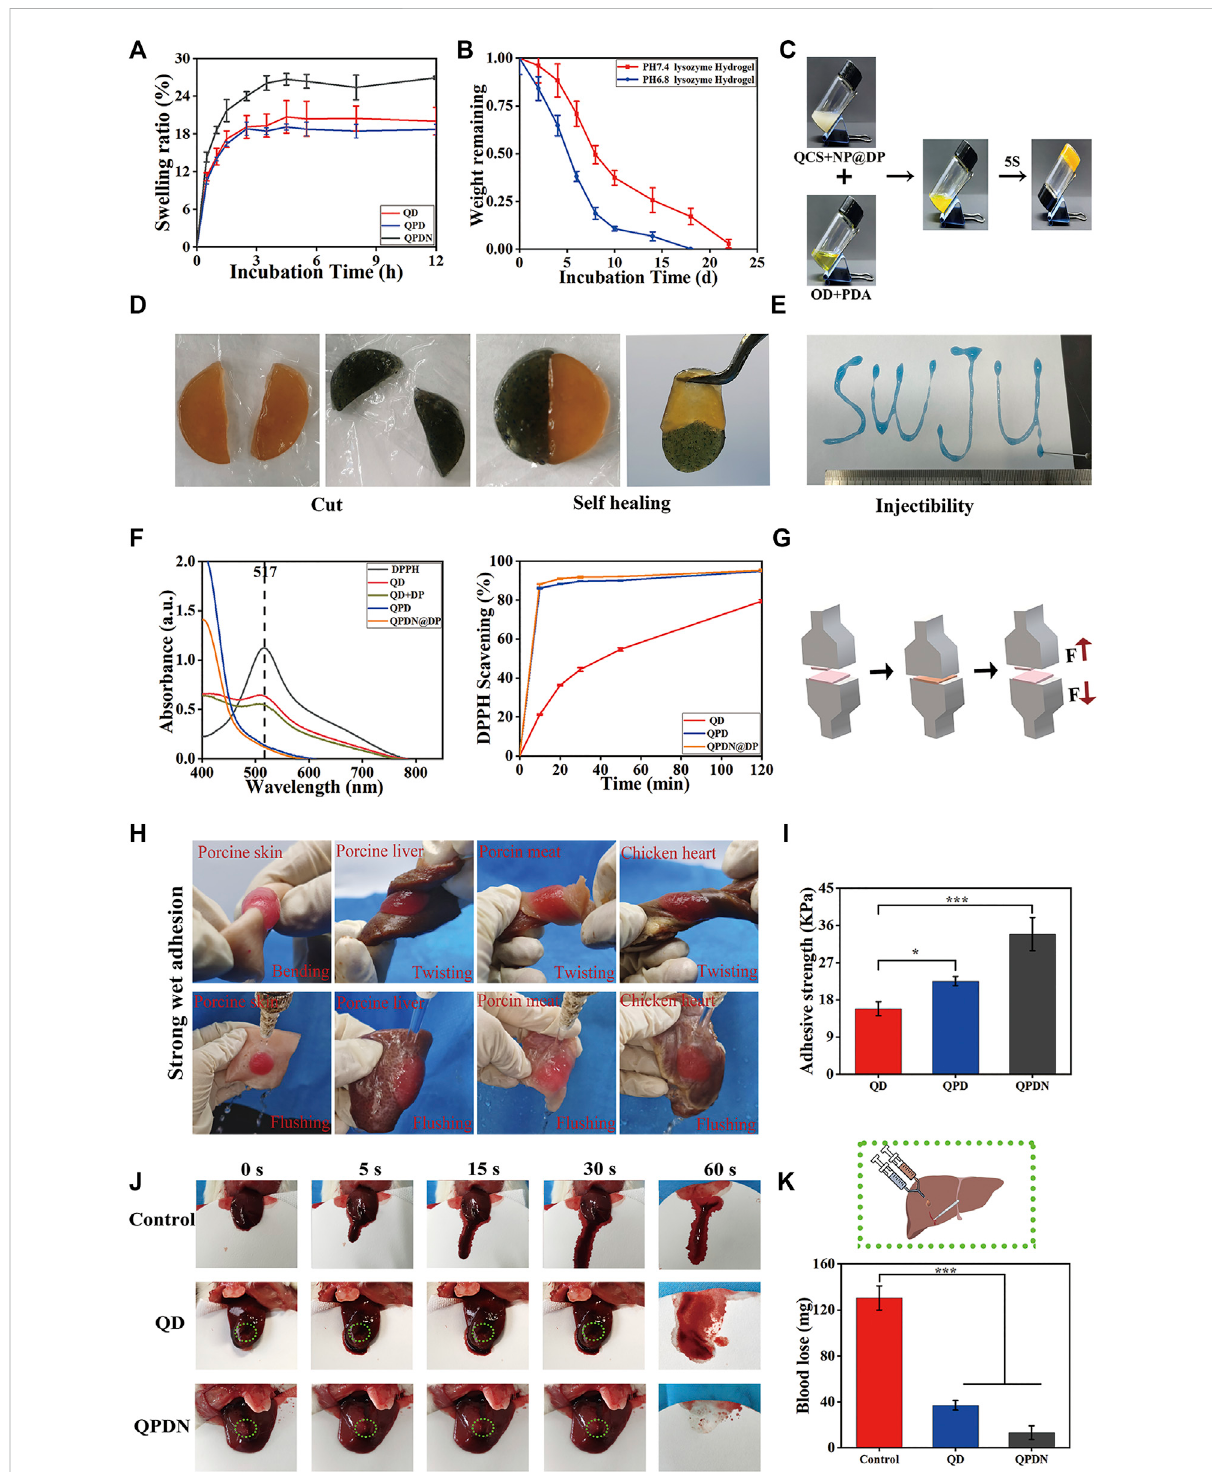
FIGURE 3 (A) Swelling properties. (B) Degradation pro fi les. (C) The optical images of hydrogels via a tube inverted test. (D) Appearance of self-healing process between two different colored semicircle hydrogels. (E) The injection process of QPDN hydrogel, SWJU was drawn. (F) Clearance curve of DPPH at30 min and The radicalscavenging rateof hydrogel inDPPH solution. (G) Schematic diagram ofadhesionmeasurement. (H) Photographs of wet adhesion of QPDN hydrogels on different tissues. (I) Comparison of Adhesion Strength of Hydrogels in Each Group (J) Photographs of liver wound with different treatments at predetermined time intervals (0, 5, 15, 30, and 60 s) (K) Schematic diagram of liver hemorrhage treatment; Total blood loss from rat liver wound after 60 s with different treatments. Mean ± SD ( n = 3). * p < 0.05, ** p < 0.01, *** p <